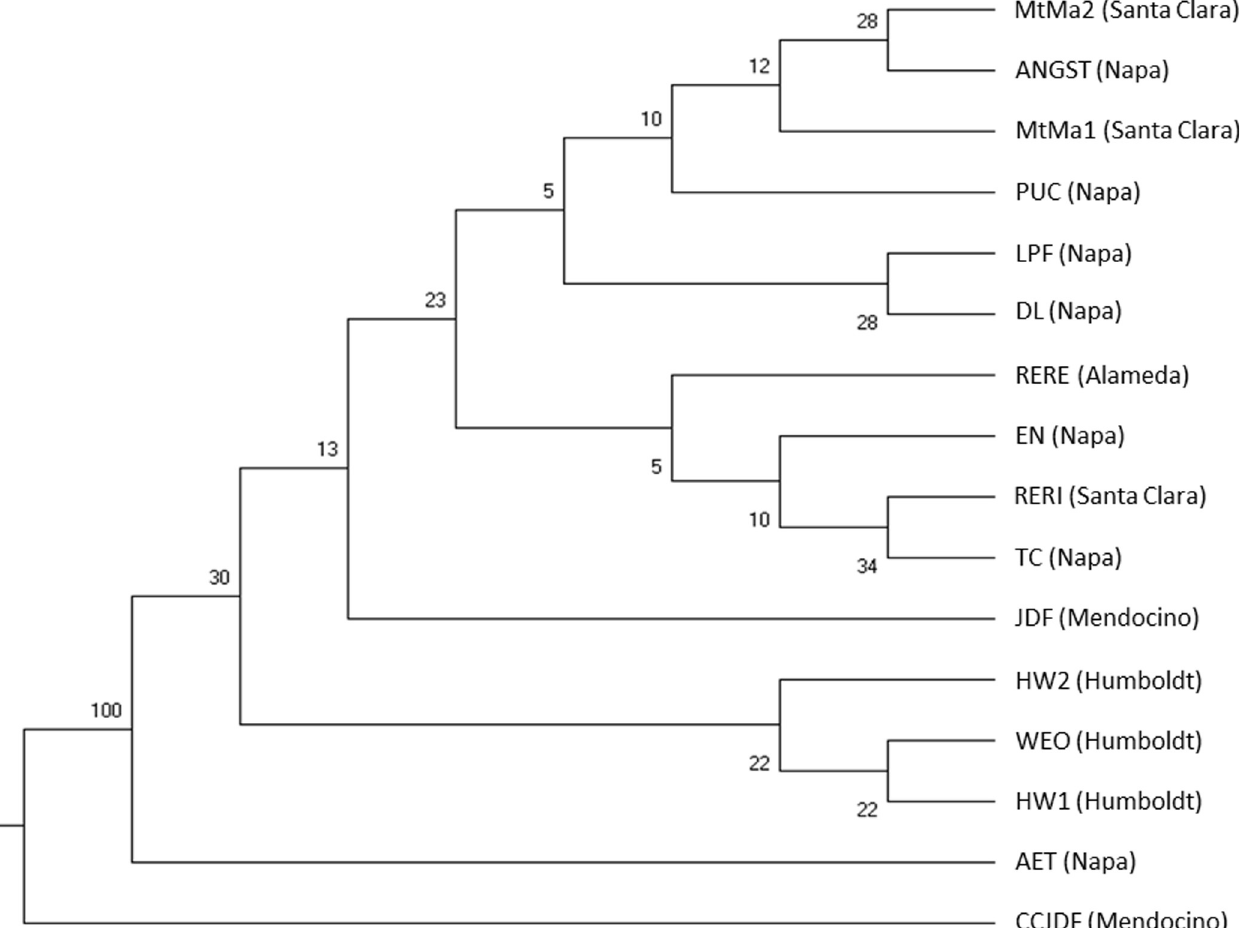
Fig 4. The neighbour-joining tree (NJT) for populations in the Californian data set C based on Nei’s genetic distance ([47] after [48]) calculated using 12 nuclear SSR markers. County names of the sampled locations are in brackets. Bootstrap values are presented as percentage. trees to the southern or northern populations divided by the San Francisco Bay in the refer- ence data set C with scores above 48% were in agreement with the assignments in the reference data set F (Tables 1 and S8). Samples with scores below 48% were assigned inconsistently between the two references, to geographically very different watersheds. For example, B11 and SF77 were assigned to RERI south of the San Francisco Bay (watershed O) based on the refer- ence data set C, but to Del Norte close to the Oregon border (watershed B) based on reference F (Fig 1 and S8 Table). The individuals from the Sequoiafarm, which were half- or full siblings according to the owner, were assigned to various watersheds (F) and locations (C). We used also pairwise individual tree genetic distances between all 396 trees in German (G), French (F) and Californian (C) data sets based on similarity in composition of their Q -val- ues for cluster analysis to assign individual German trees to a particular watershed or a sub- population by generating NJTs and PCoA plots, which are presented in S9–S12 Figs, respectively. The individual Q -values for K = 17 (number of watersheds) and K = 30 (total number of subpopulation samples or groups except German sample) and genetic distance based on them for all 396 trees in German (G), French (F) and Californian (C) data sets are